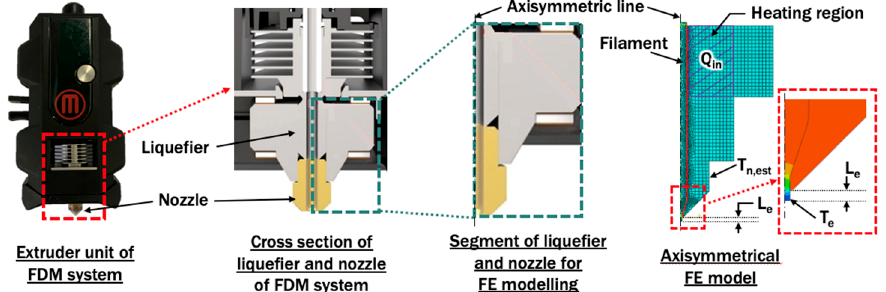
Figure 2. Development of axisymmetrical finite element model from actual extruder unit of FDM.